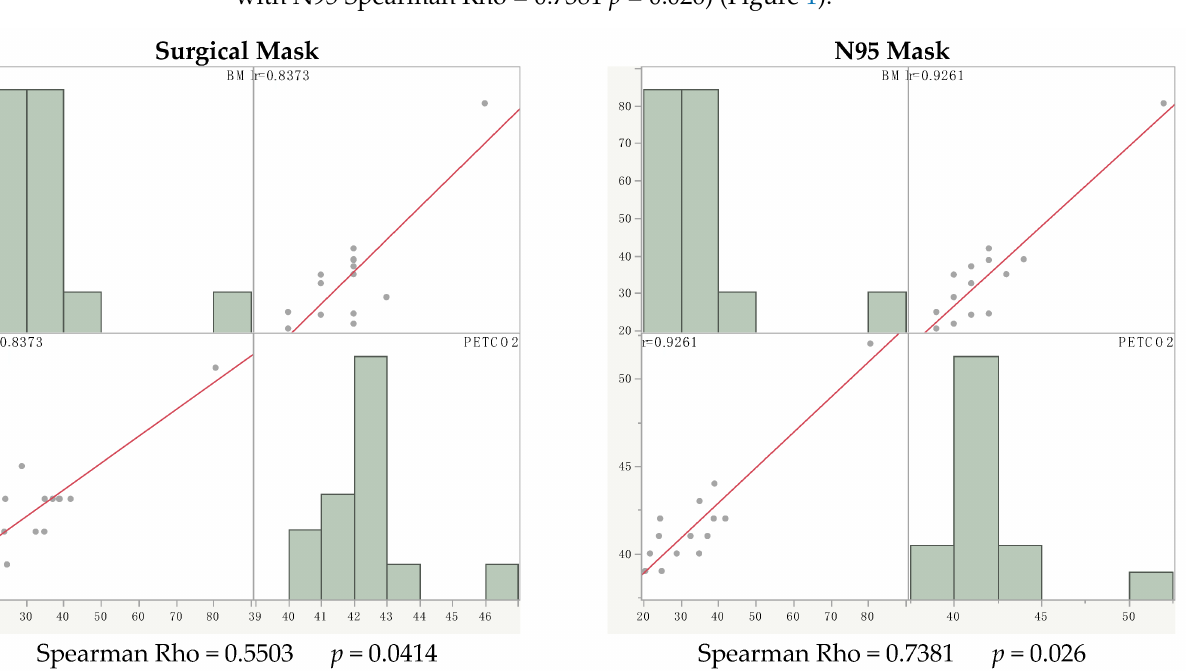
Figure 1. Spearman’s Rho (r) correlation between the degree of obesity (BMI) and the levels P ETCO2 after the walking test wearing surgical mask (SM) and N95 mask (N95). The above figure is a comparison between the group of healthy children and the group of overweight and obese